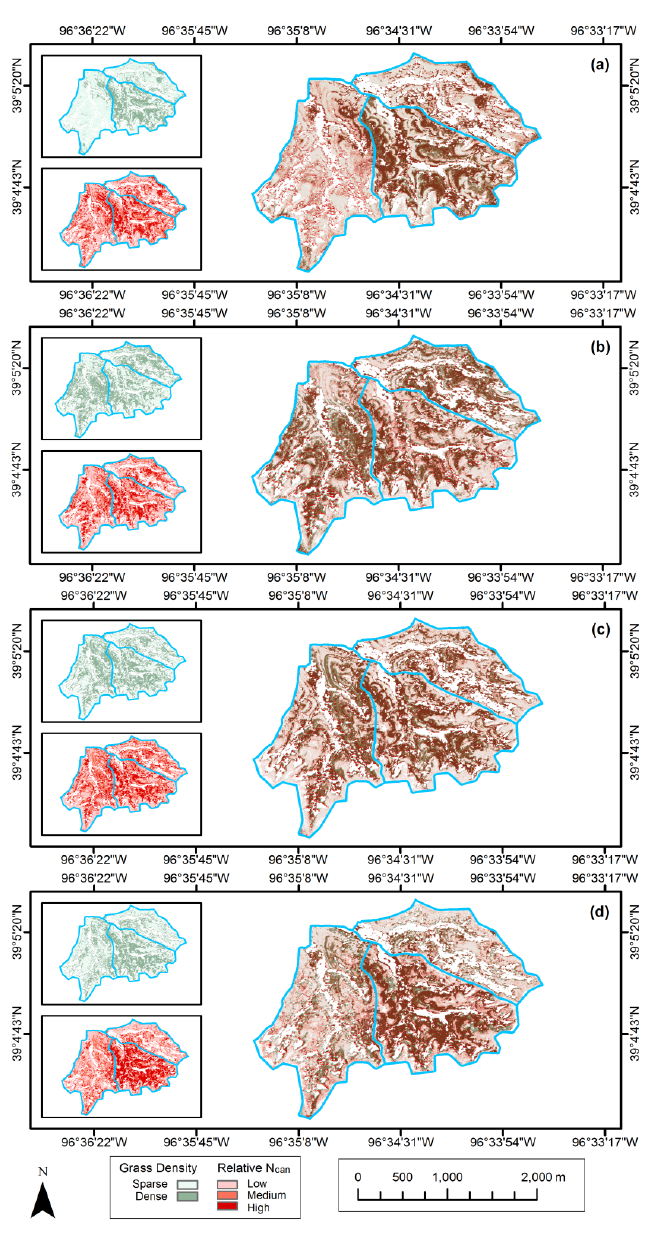
Figure 7. Comparison between N can stratification and grass density in selected watersheds at KPBS in ( a ) May, ( b ) July, ( c ) August, and ( d ) September. Overlaps of high N can level and dense grasses are in the dark shade; low N can level and sparse grasses are in the